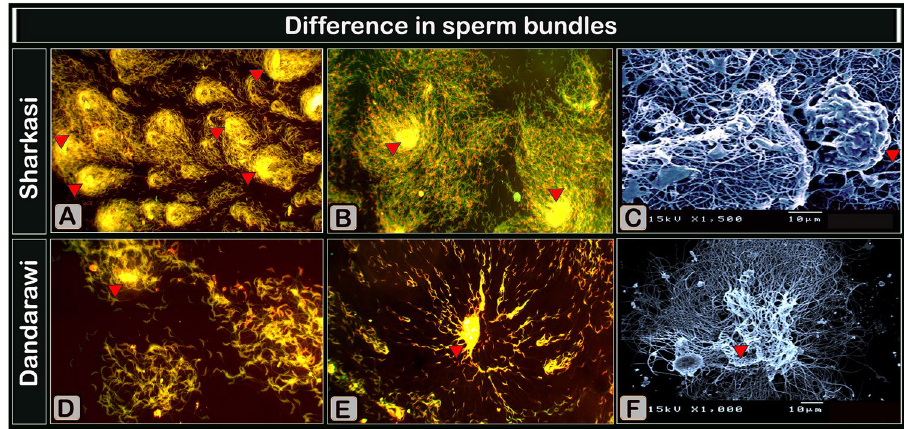
Figure 3. Acridine orange-stained sperm smears ( A , Magnification × 200, B , Magnification × 400, D , Magnification × 400, E Magnification × 400,) and digitally colored scanning electron micrographs ( C , F ) images of sperm bundles. ( A , B , D , E ) are micrographs of sperm smear stained with Acridine orange and showing a network of adherent multiple sperm, whereas C and F are digitally colored scanning electron micrographs of sperm. ( A , B ) Many aggregations of Sharkasi sperm showing their high tendency of agglutination (sperm heads covered by a secretion or coat showing that sperm bundles were held by extracellular substances “agglutinating substance”, yellow color, arrowheads). ( D , E ) Few and small aggregations of Dandarawi sperm showing less tendency of agglutination and more scattered lonesome sperm. ( C ) Sharkasi sperm aggregates forming a network of adhered tails and heads (arrows) coated by a dense coat (agglutinating substance, arrowheads). ( F ) Dandarawi sperm aggregations with less dense agglutinating substance (arrowheads).